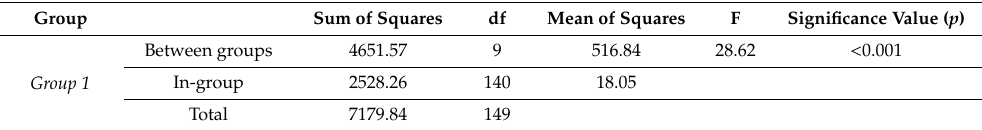
Table 3. Statistical comparison of Group 1 means.